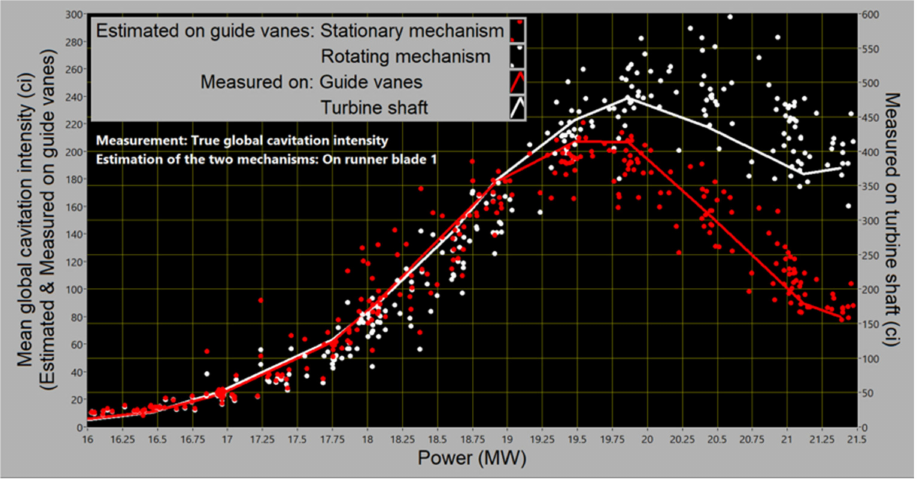
Figure A7. Estimates (dots): as in Figure A6. Measurement (curves): I (